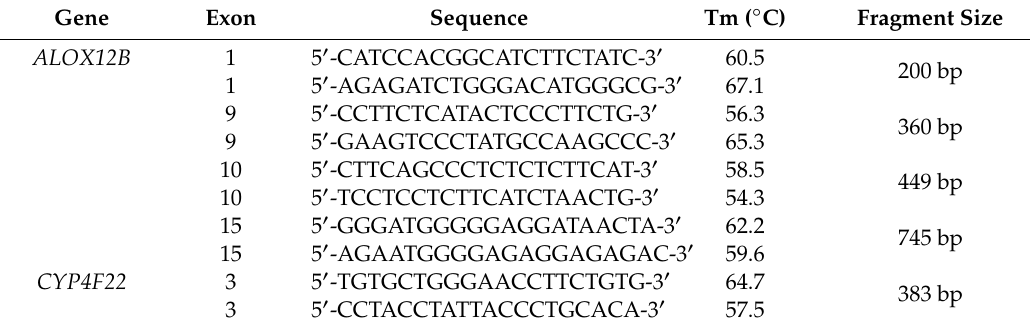
Table 1. List of primer pairs used for qPCR gene dosage assay.